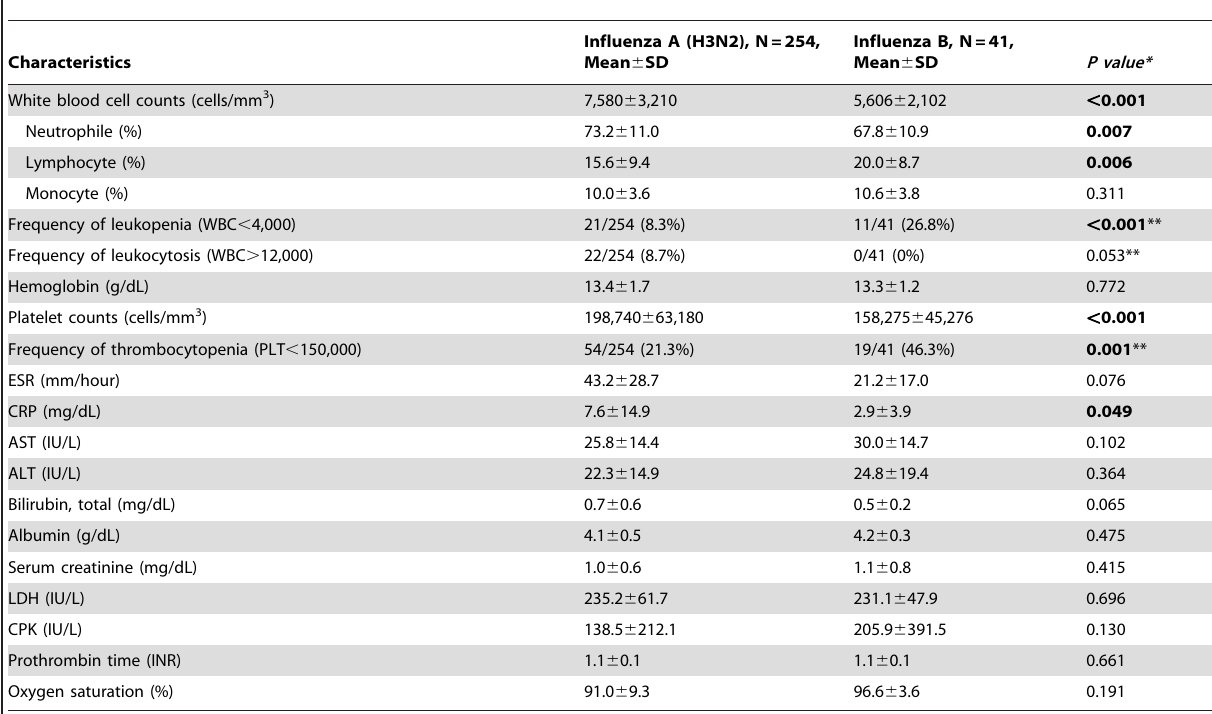
Table 3. Routine laboratory findings in patients with laboratory-confirmed Influenza A (H3N2) and Influenza B from October 2011 to May